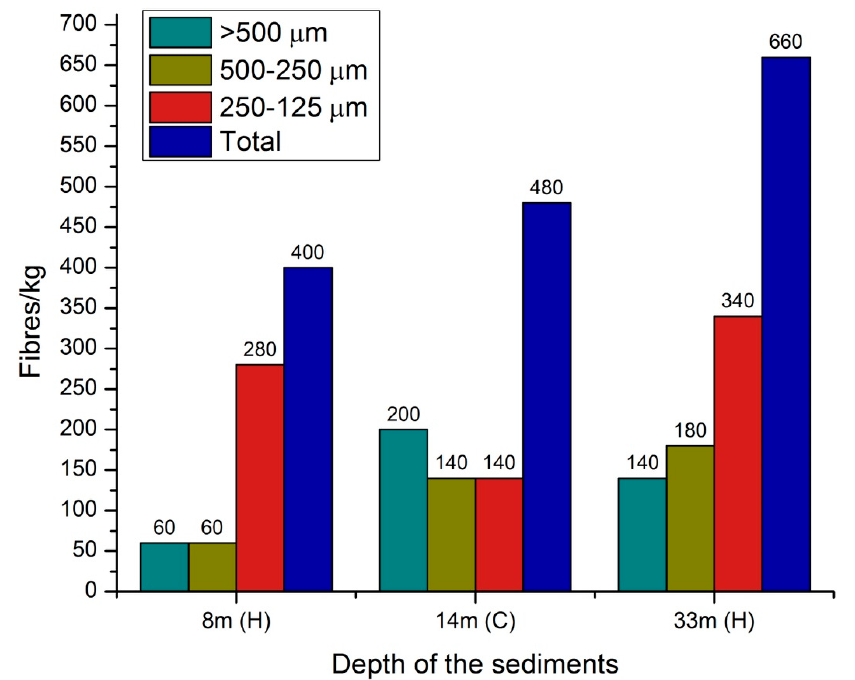
Figure 8. Number of fibres per kilogram in each size fraction of the sediment samples in Lake Sassolo indicating a significant contamination. On average, the number of fibres was equal to 514 fibres/kg of sediment.